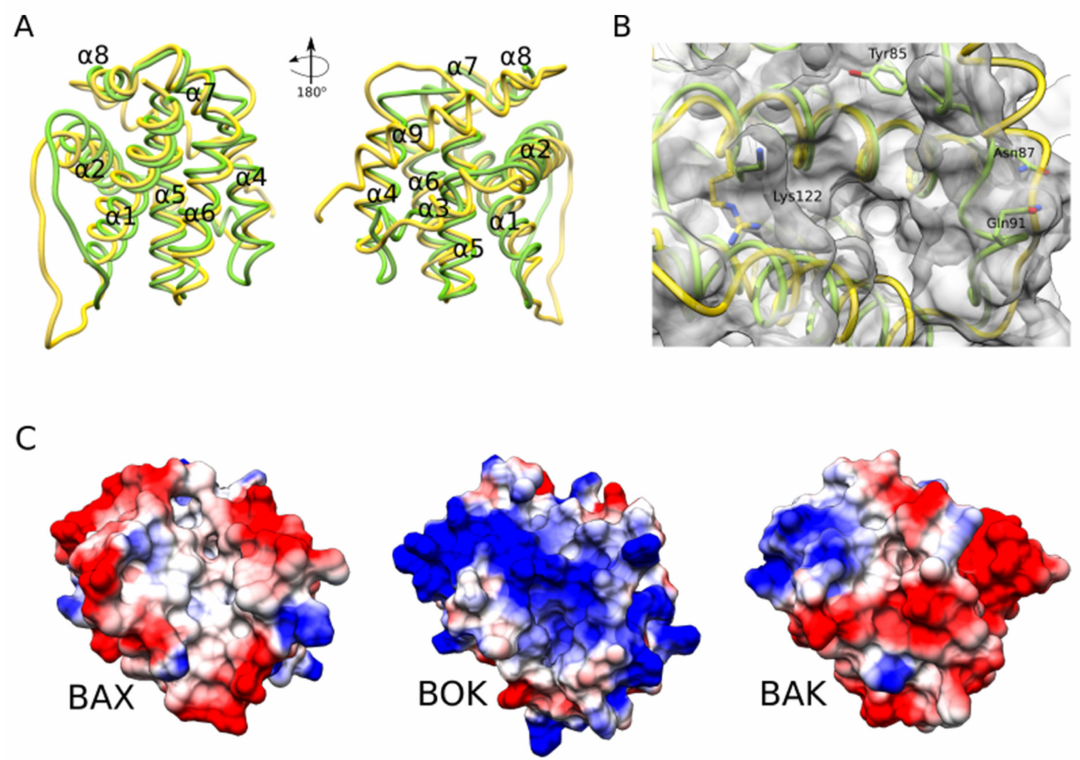
Figure 3. Insights from BOK NMR structure. ( A ) Superposition of the structures of BOK (green) and BAX (yellow) showing the similar fold of the two proteins. The helix numbers are indicated with the helix α 9 resolved only in BAX and occupies the hydrophobic groove. ( B ) Zoomed view on the hydrophobic groove from A with key residues displayed as sticks. The helix α 3 of BOK is distorted and drifts more into the groove compared to BAX. Tyr85 residue is protruding inside the groove, which hinders the binding of the BH3 ligand. Lys122 is special to BOK (Arginine in all other family members) and forms a weaker interaction with the conserved aspartate in the BH3 ligand. ( C ) Electrostatic surface representation (red ( − 5kT / e) to blue ( + 5kT / e)) of the hydrophobic groove side of BAX, BOK, and BAK. As shown, BOK appears to be more electropositive compared to the other two